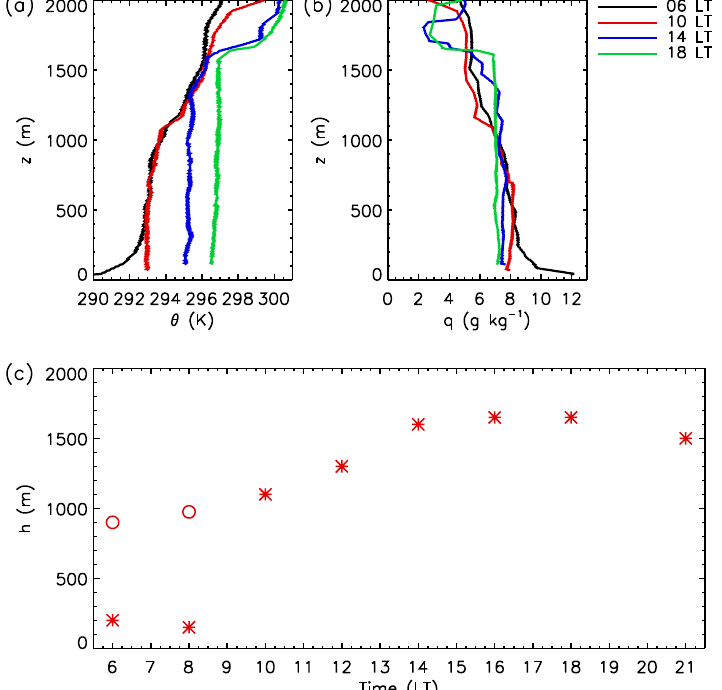
Fig. 4. Evolution of the vertical profiles of (a) the potential temperature and (b) specific humidity as measured by radiosondes on 6 August 2010 (6:00, 10:00, 14:00 and 18:00 LT). In (c) the evolution of the boundary layer height is presented, derived from all vertical profiles observed during that day. Asterisks indicate the height of the boundary layer, while circles represent the height of the residual layer in the morning. The shallow boundary layer connects with the residual layer between 8 and 10 LT.